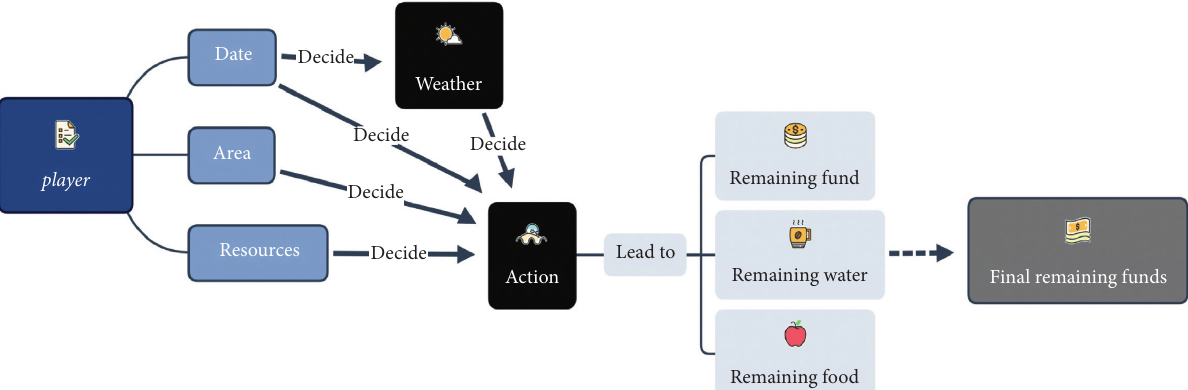
Figure 9: The flowchart of the player